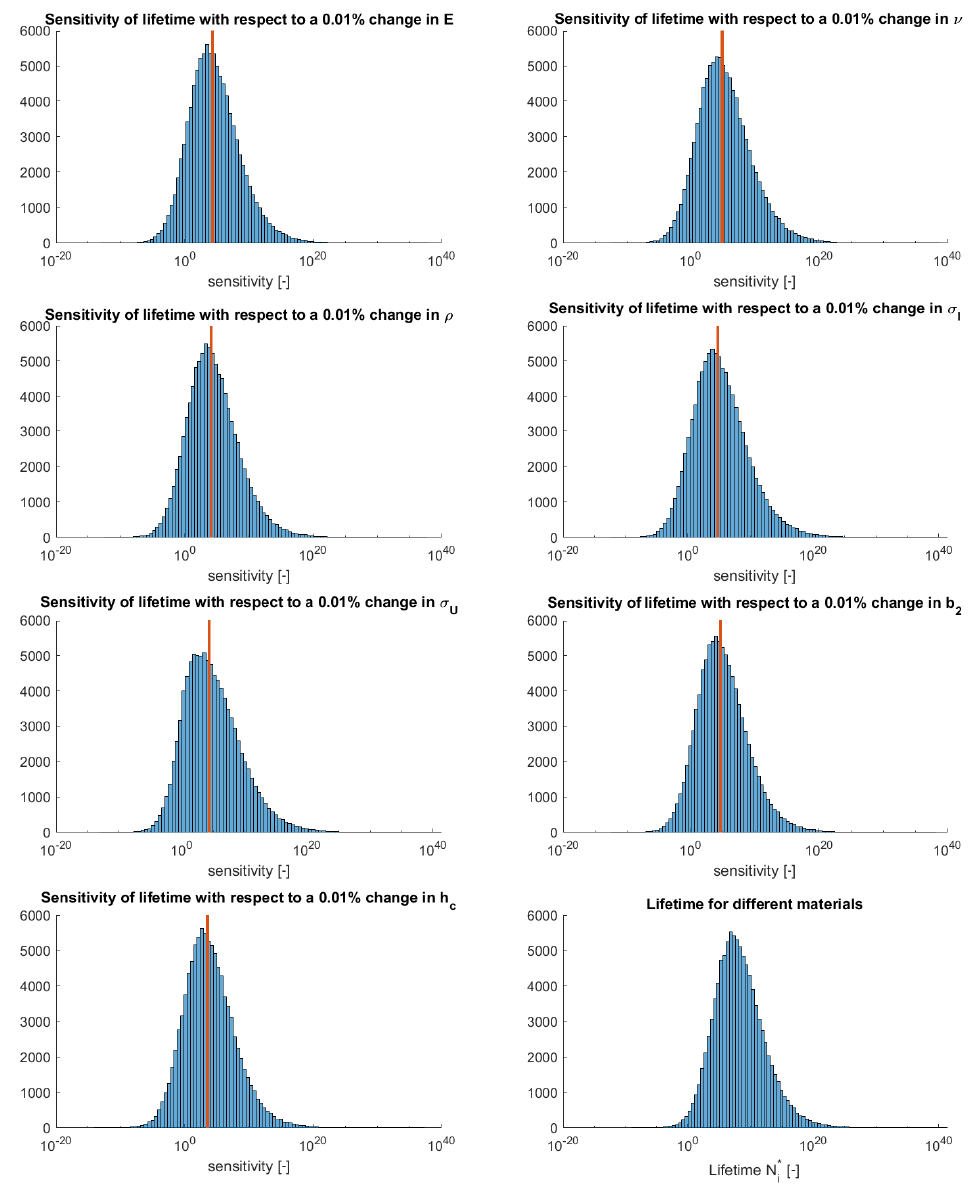
Figure A1. Distributions of sensitivities and lifetimes for the global sensitivity